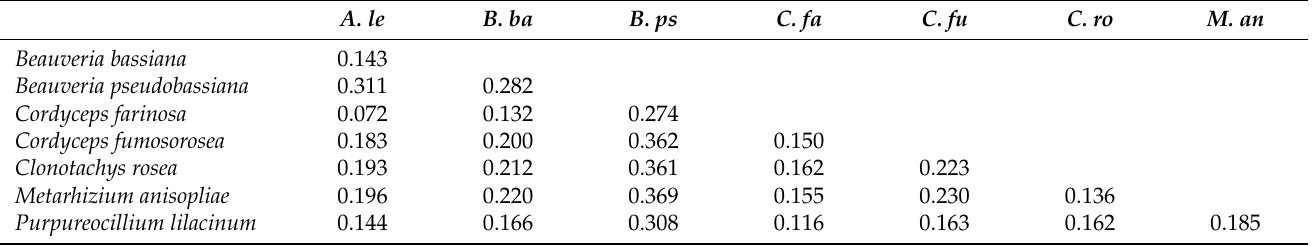
Table 3. Nei’s genetic distance matrix of eight EPF species obtained from